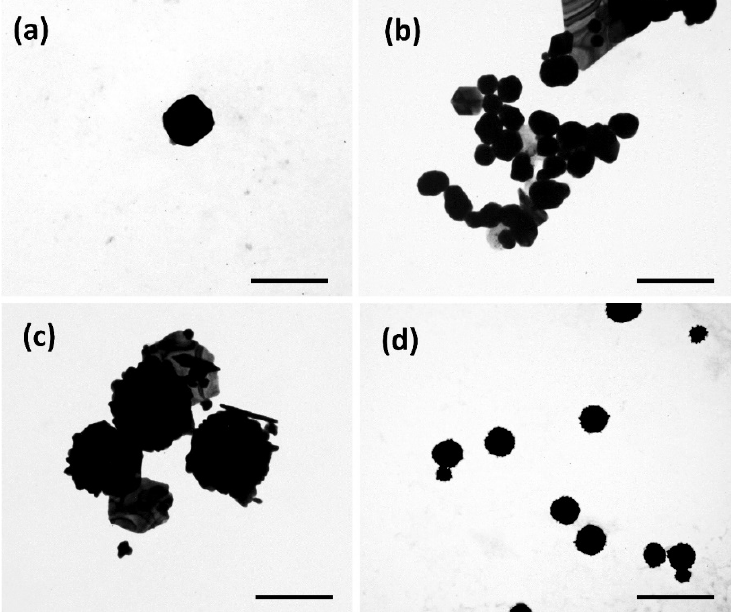
Figure 3. Morphological characterization of AuNPs by TEM. ( a ) Ratio 1, scale bar = 300 nm; ( b ) Ratio 2, scale bar = 200 nm; ( c ) Ratio 3, scale bar = 400 nm; ( d ) Ratio 4, scale bar = 400 nm.